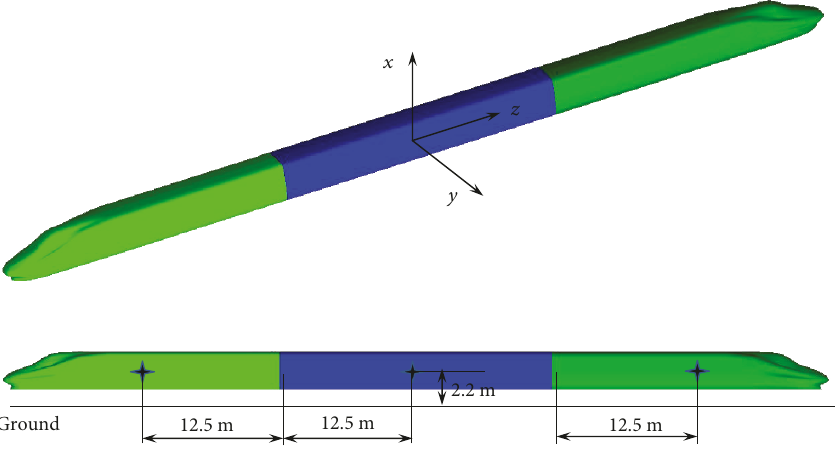
Figure 14: Diagram of aerodynamic moment